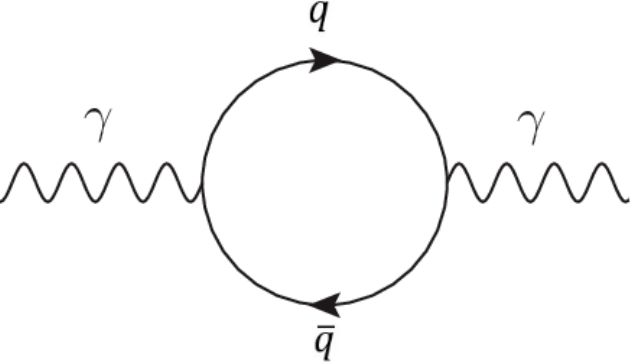
Figure 1. The lowest-order correction to the vacuum polarization Π ρσ of photons, due to quarks of the flavor q